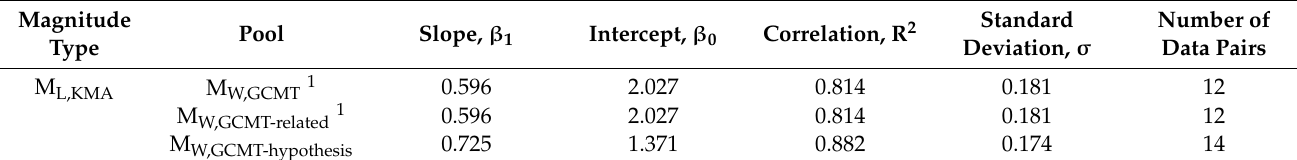
Table 11. Magnitude homogenization regression results from all moment magnitude pools for local magnitude types from DJA.